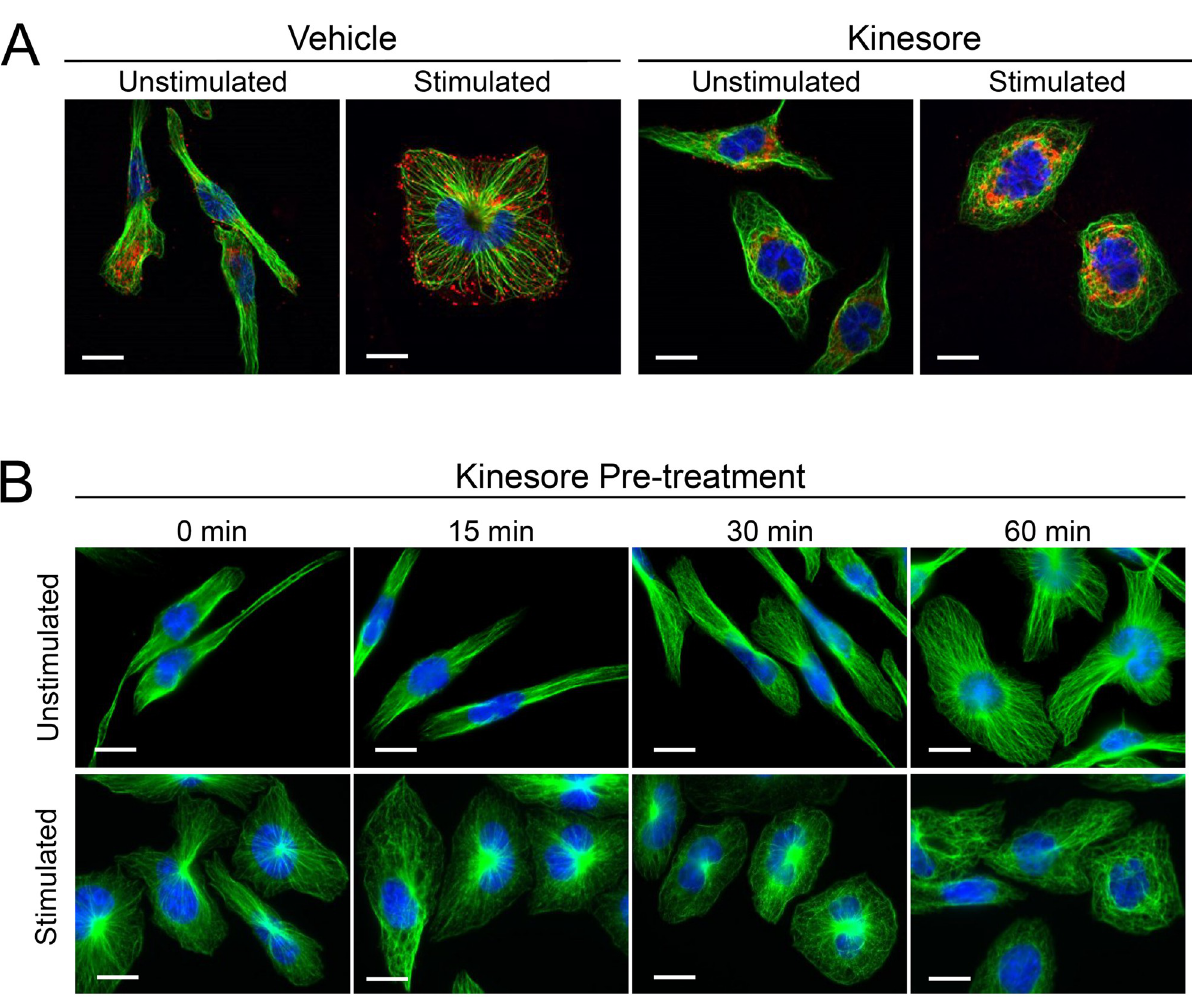
Fig 6. Kinesore treatment of mast cells affects microtubule structures independent of its effect on granule distribution. A) RBL-2H3 cells were pretreated for 30 min with vehicle (DMSO), or 100 μ M kinesore. Cells were left unstimulated, or antigen-stimulated for 30 min, fixed and stained for nuclei (blue), microtubules (green), or CD63+ granules (red). Granule distribution to the cell periphery is disrupted by kinesore treatment. Microtubule structures that normally project linearly to the cell periphery were disrupted by kinesore treatment. B) RBL-2H3 cells were pre-treated for 0 min, 15 min, 30 min or 60 min with kinesore then fixed (unstimulated), or antigen-stimulated for 30 min then fixed and stained for nuclei (blue) and microtubules (green). Microtubule linear structures were disrupted by kinesore after 30 min. Scale bar, 10 μ m.